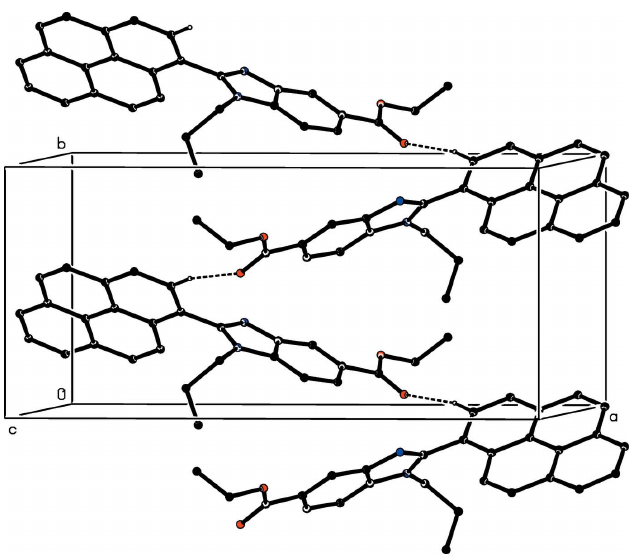
Figure 5 Part of the crystal structure of compound (II) showing the formation of a hydrogen-bonded C (10) chain parallel to [010]. Hydrogen bonds are drawn as dashed lines and, for the sake of clarity, the H atoms not involved in the motif shown have been omitted.